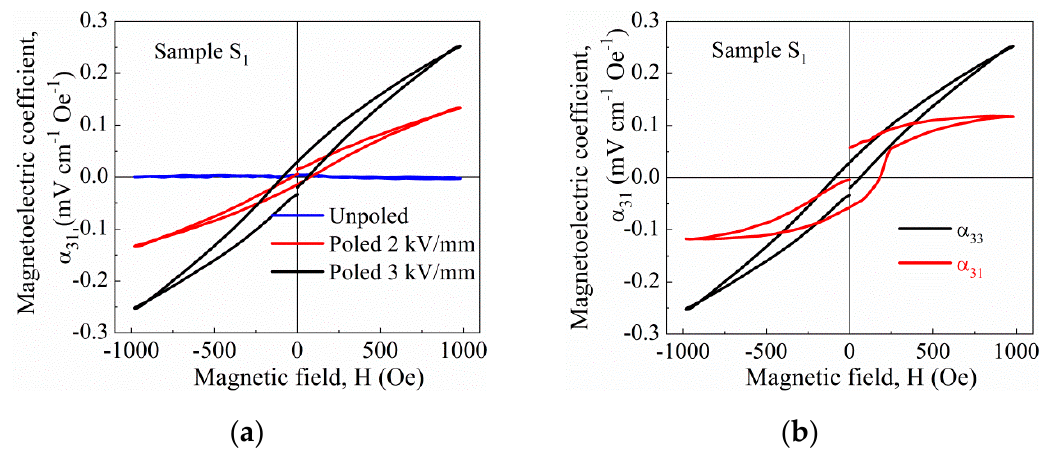
Figure 15. Room-temperature magnetoelectric coefficients as a function of DC magnetic field of BNT–BT 0.08 /CoFe 2 O 4 core-shell ceramic with a 1:0.5 molar ratio (sample S 1 ): ( a ) measured in the longitudinal mode ( α 33 ) after poling at increasing electric fields, and ( b ) measured in both longitudinal ( α 33 ) and transverse ( α 31 ) modes after poling at 3 kV/mm.